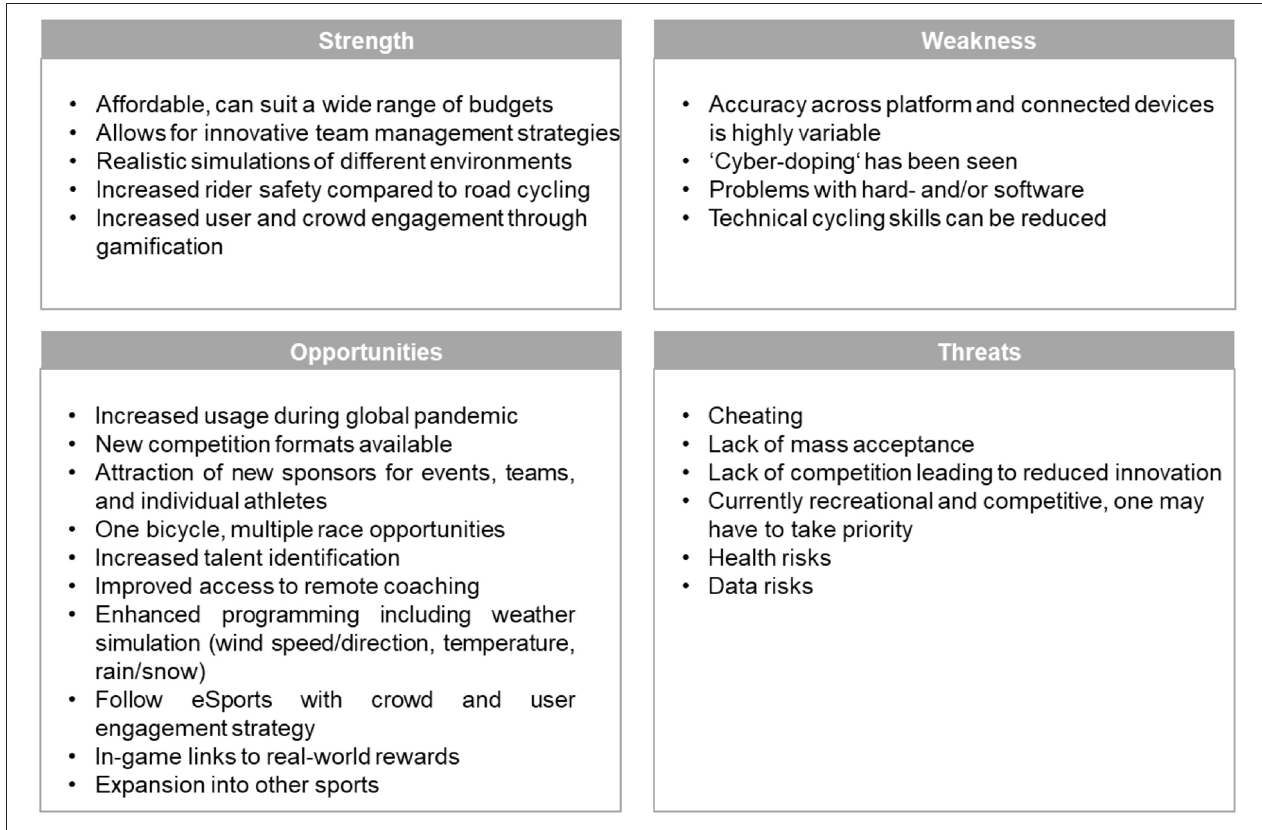
FIGURE 1 | A summary of strengths and weaknesses, as well as opportunities and threats associated with virtual training in